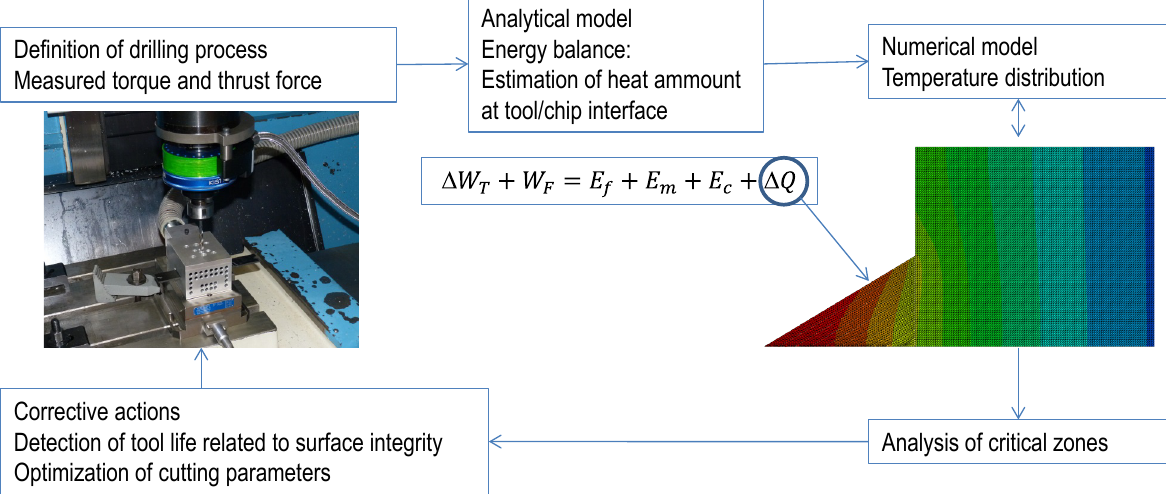
Figure 1. Relationships between experimental, analytical, and numerical steps